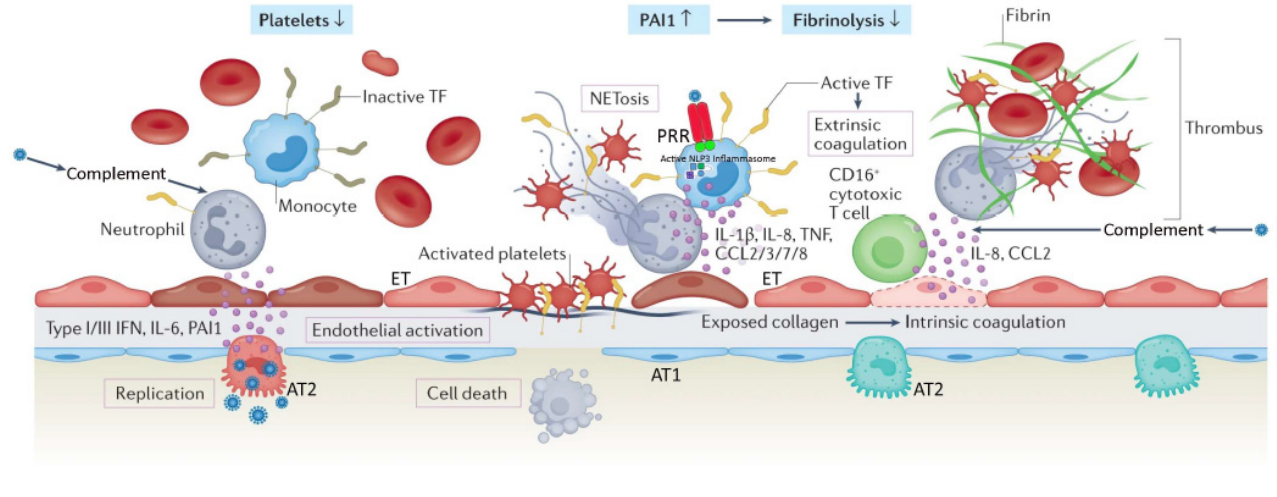
Figure 1. Severe coronavirus disease 19 is characterized by immune cell-mediated hypercoagulability and hypofibrinolysis. Hypoxia, cytokines, chemokines, damage-associated molecular patterns, and direct infection by the virus contribute to alveolar and endothelial cell death, and disruption of the alveolar–capillary barrier. Exposed extracellular matrix can trigger both the extrinsic coagulation (via tissue factor (TF)) and the intrinsic coagulation (via collagen/RNA). Recruited monocytes (with virus-activated NLP3 inflammasomes) and neutrophils amplify the inflammatory response, as well as the activation of coagulation by expressing active tissue factor (TF) and releasing neutrophil extracellular traps (NETs), respectively. Complement activation by the virus promotes active TF expression by neutrophils, and differentiation of cytotoxic CD-16 + T cells. NETs recruit platelets, which are subsequently activated by NET histones and the C3a and C5a complement fragments; this results in platelet release of cytokines. Activated platelets secrete coagulation-sustaining factors. The immunothrombotic process leads to diffuse small-vessel thromboses and thrombocytopenia. Concurrently, increased expression of plasminogen activator inhibitor (PA1) attenuates fibrinolysis. AT1 , alveolar type 1 cell; AT2 , alveolar type 2 cell; ET , endothelial cell; PRR , pattern recognition receptor; IL , interleukin; CCL , CC chemokine ligand; IFN , interferon. Reproduced in part with per- mission from [26]; copyright (2022) by Springer Nature.